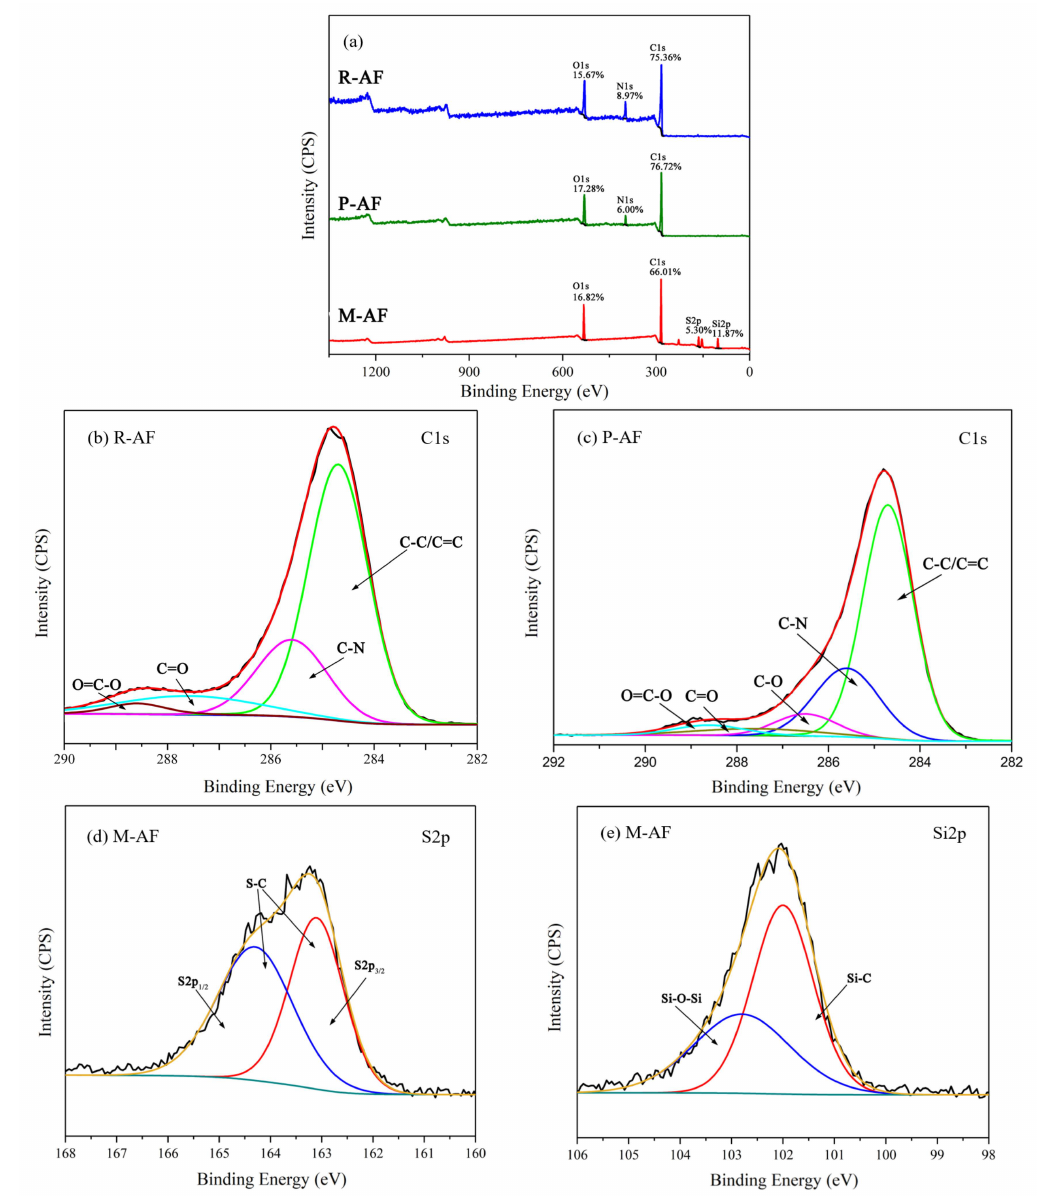
Figure 9. XPS wide-scan spectrum ( a ), C1s high-resolution spectra of ( b ) R-FA and ( c ) P-AF, S2p ( d ) and Si2p, and the ( e ) high-resolution spectra of